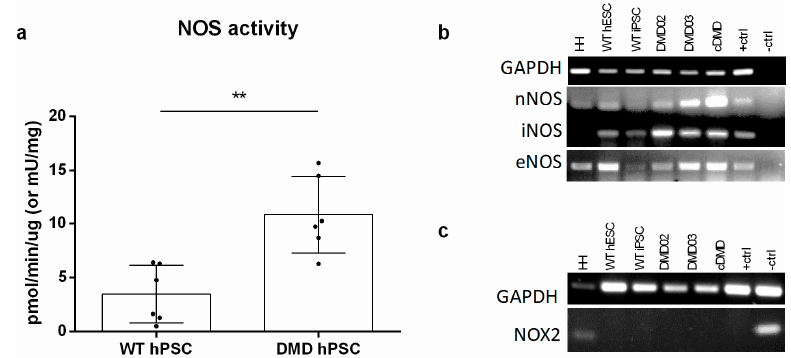
Figure 4. Enzymatic NOS activity is increased in DMD hPSC lines. ( a ) NOS activity assay showed increased production of NO (in pmol/min/ µ g) in DMD hPSC lines when compared to WT hPSC. 6 independent repetitions (for each WT and DMD hPSC) were used for the analysis. Student t -test was used for statistical evaluation of significance (** p < 0.01). Errorbars show standard deviation. ( b ) All three NOS isoforms (nNOS, iNOS and eNOS) are expressed in WT as well as in DMD hPSC. For a positive control (+ctrl), HH (for NOX and nNOS), hepatocytes (for iNOS) or RPMI myeloma cells (for eNOS) were used. Water instead of cDNA was used for negative control ( − ctrl). GAPDH was used as loading control. ( c ) mRNA analysis revealed that NOX2, is not expressed in pluripotent state. Human heart tissue (HH) was used as positive control, GAPDH was used as loading control. At least 3 biological repetitions were used in each experiment, exact value for each is represented by • in each graph